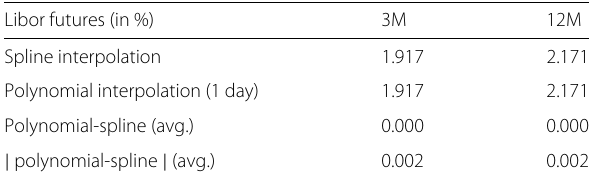
Table 8 Interpolation of LIBOR futures Libor futures (in %) 3M 12M Spline interpolation 1.917 Polynomial interpolation (1 day) 1.917 2.171 Polynomial-spline (avg.) 0.000 0.000 | polynomial-spline |